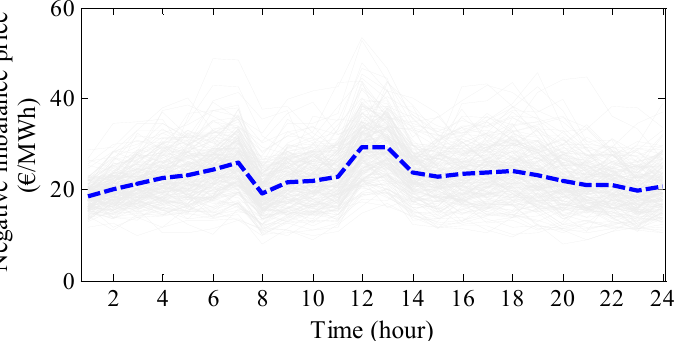
Figure 4. Scenarios and mean of positive imbalance price.